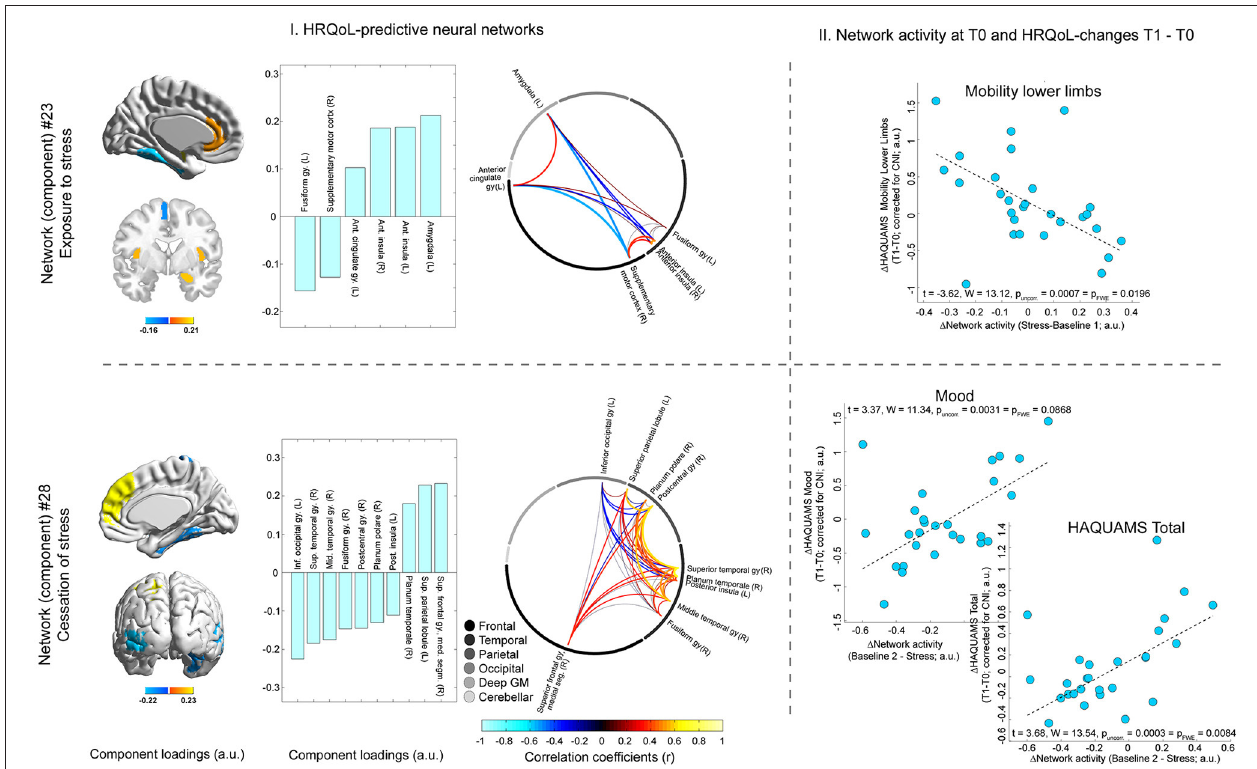
FIGURE 5 | Neural network activity and future HRQoL evolution. T0 activity of one network (network #23, shown in the upper row of the figure) triggered by stress exposure (which was reflected by the difference in network activity for stress minus baseline I) was predictive of future variations in lower limb mobility. The activity of another network (#28, shown in the lower row of the figure) triggered by cessation of stress (reflected by the differential network activity for baseline II minus stress) was predictive of future variations in overall HRQoL (i.e., total HAQUAMS score) and mood. The left side of the figure (“I. HRQoL-predictive neural networks”) depicts different features of the two networks. In particular, the rendered brains in the leftmost column of (I.) and the bar graphs to their right depict individual brain regions included in the neuroanatomical atlas related to the predictive networks and the strength and direction of this relation (i.e., their component loadings; see Supplement for details on the computation of these loadings as well as a comprehensive overview of loadings of all atlas regions). The circular network graphs on the rightmost side of (I.) illustrate the intercorrelations of manifest regional signals for areas belonging to a given network. It is noted that the strength and direction of these intercorrelations do not only depend on the fact that the given regions are all maximally related to the same network but also on weaker relations to other networks and that the contribution of these other networks to the activity of regions may vary across regions. The scatter graphs on the right side of the figure (“II. Network activity at T0 and HRQoL-changes T1–T0”) illustrates the associations between a given differential network activity marker (i.e., for stress or relaxation) and the temporal difference score of the given HAQUAMS parameter. Positive differences 1 HAQUAMS denote worsening in HRQoL ratings over